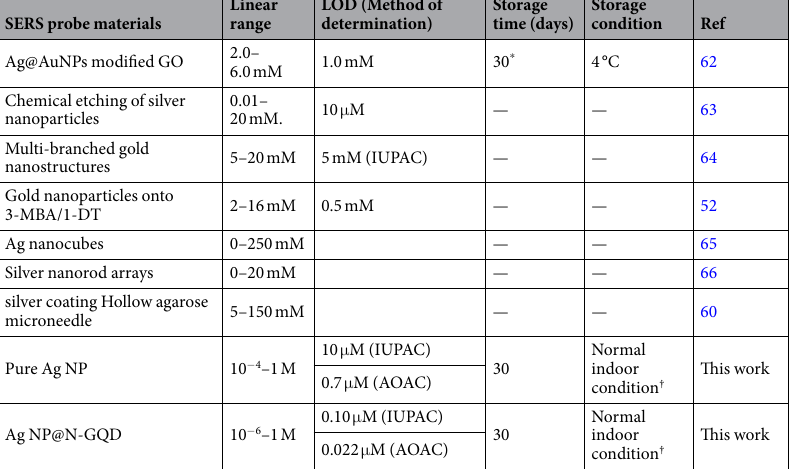
Table 1. Performance comparison of different glucose sensing techniques. LOD is the acronym of “Limit Of Detection”. The details about the methods of LOD determination are described in the section–“SERS based glucose detection” of the text. * Quantitative information about comparison in SERS performance before and after storage was not available in these reports, although the authors claimed that the SERS substrates worked well after the specified storage period. † Normal indoor condition refers to an average temperature of 25 °C and a relative humidity of 69%.